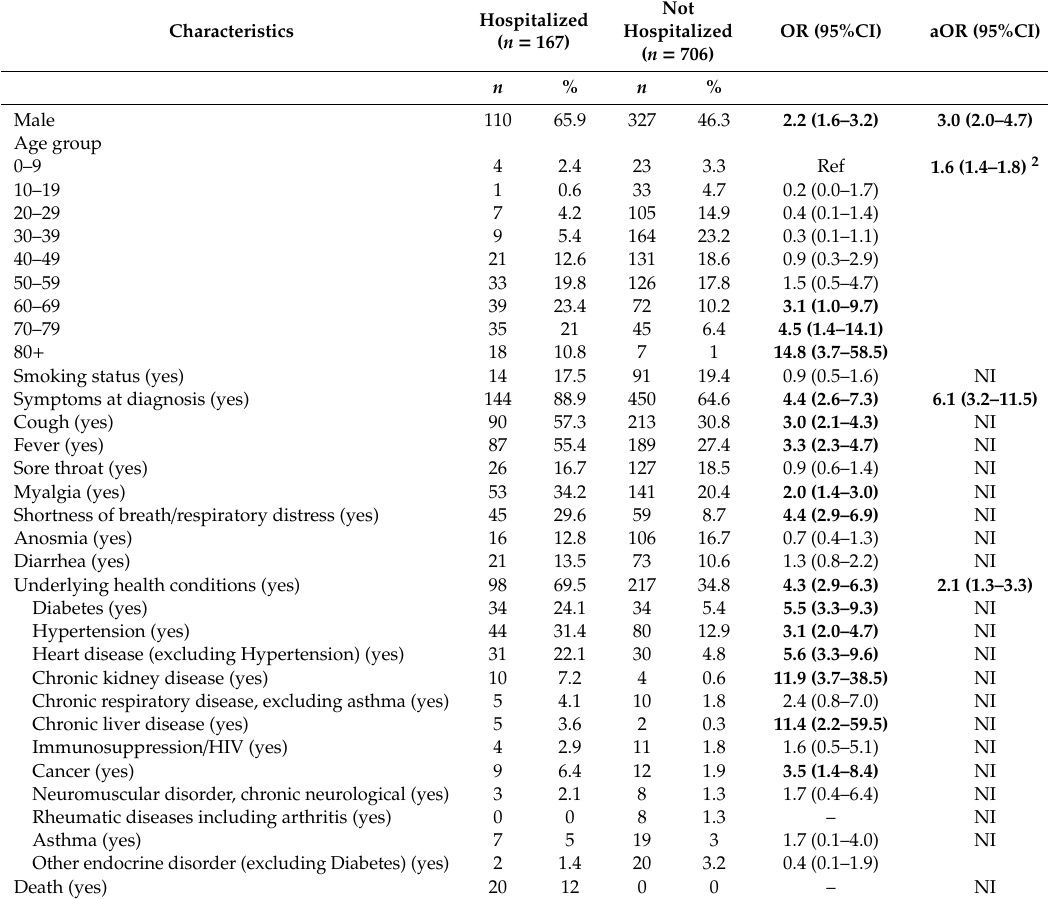
Table 2. Characteristics of cases by hospitalization status, and factors associated with hospitalization (univariate and multivariable analysis), Republic of Cyprus 9 March–3 May 2020 1